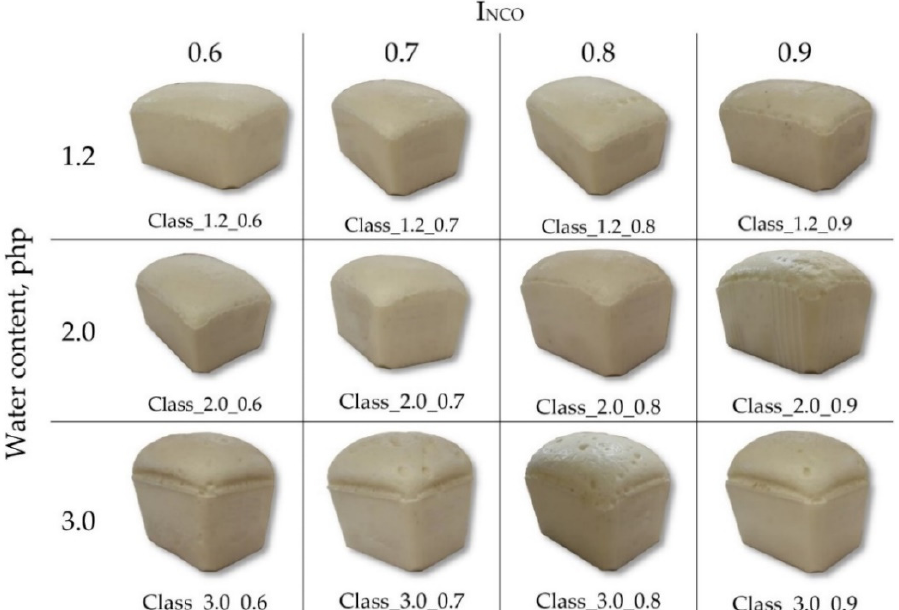
Figure 1. The appearance of the free-rise viscoelastic polyurethane foams.